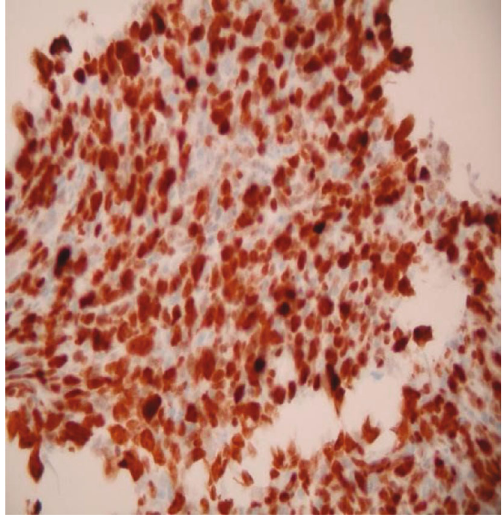
Figure 3: The soft tissue biopsy under H&E stain and high power: no atypia or malignancy noted.